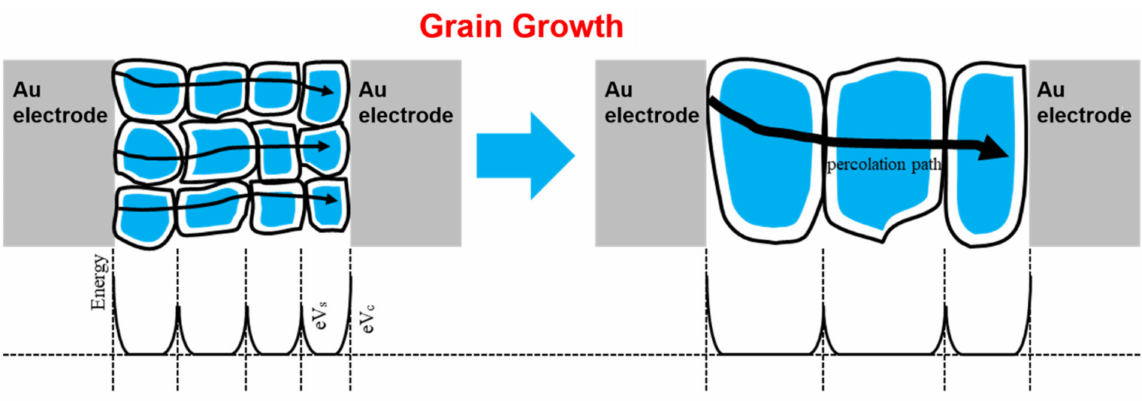
Figure 6. Schematic image of SnO 2 grain boundary and Schottky barrier with Au electrode before and after annealing.